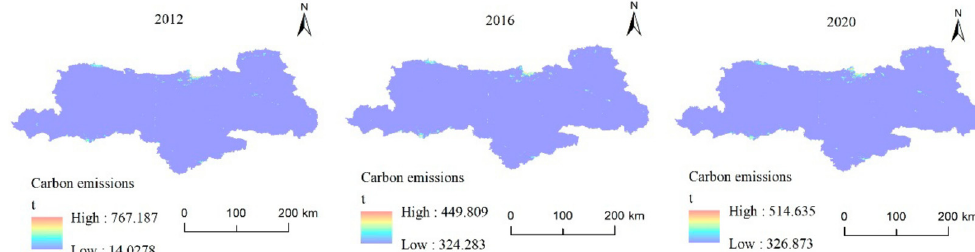
Figure 3. Temporal and spatial distribution of carbon emission in Qinling